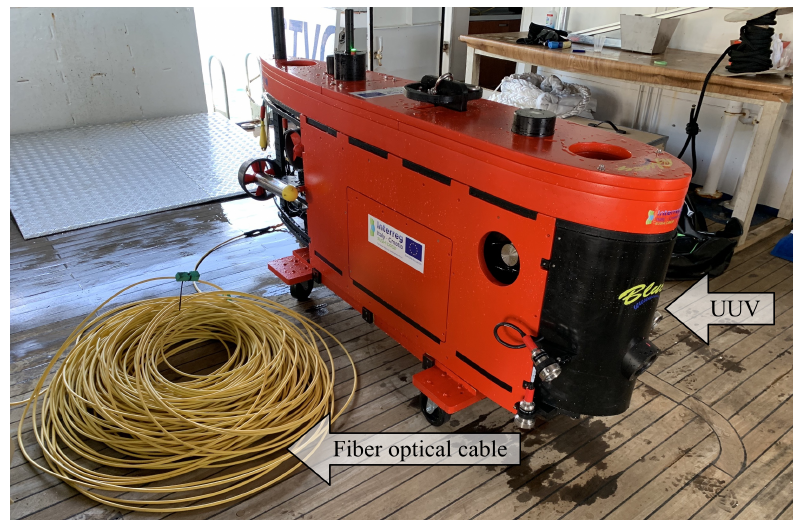
Figure 1. UUV prototype, Blucy and fiber optical cable during first tests in open